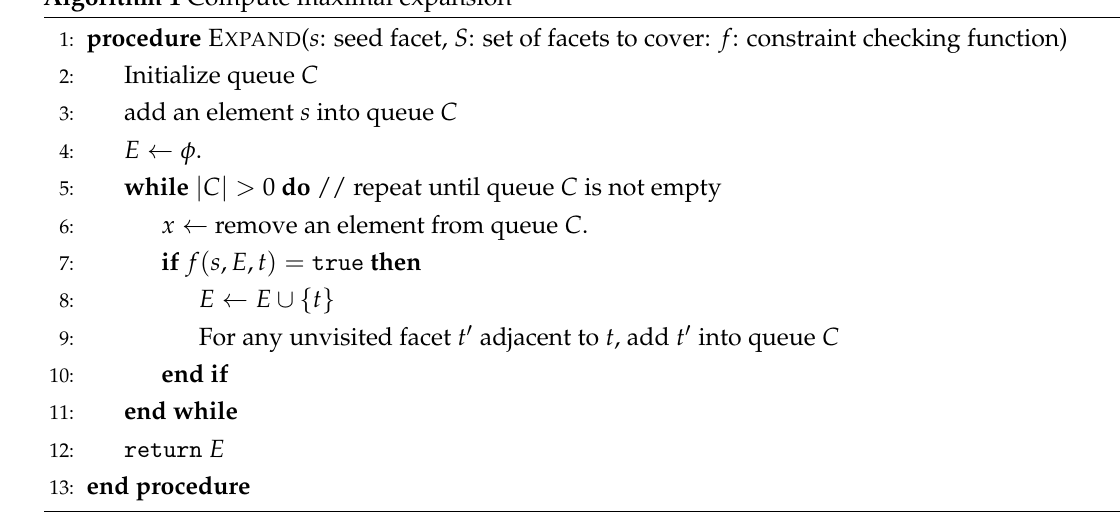
Algorithm 1 Compute maximal